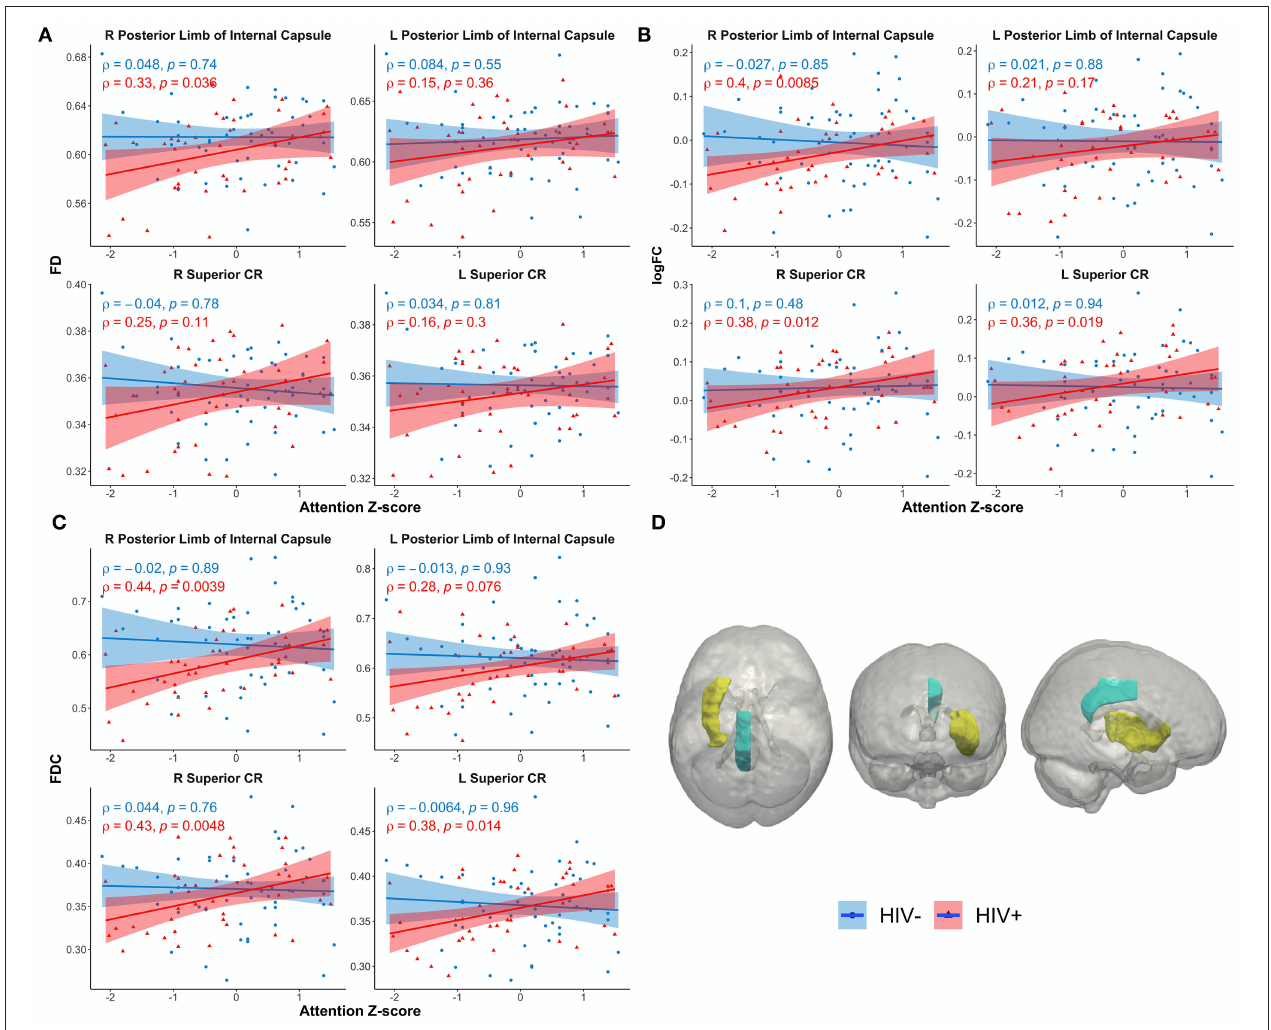
FIGURE 4 | Scatterplots show attention z -score as a function of FBA metrics: (A) fiber density (FD), (B) log of fiber cross section (logFC), (C) fiber density and cross section (FDC), (D) JHU white matter atlas and corresponding regions of interest. Only significant regions are shown. Solid lines represent linear fit, and shaded areas represent the 95% confidence interval. IC, internal capsule (yellow); CR, corona radiata (teal); CR, corona